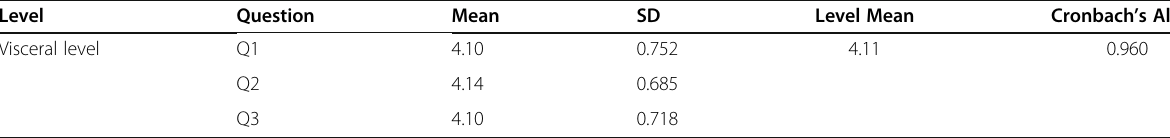
Table 2 Analysis results of the respondents ’ visceral-level